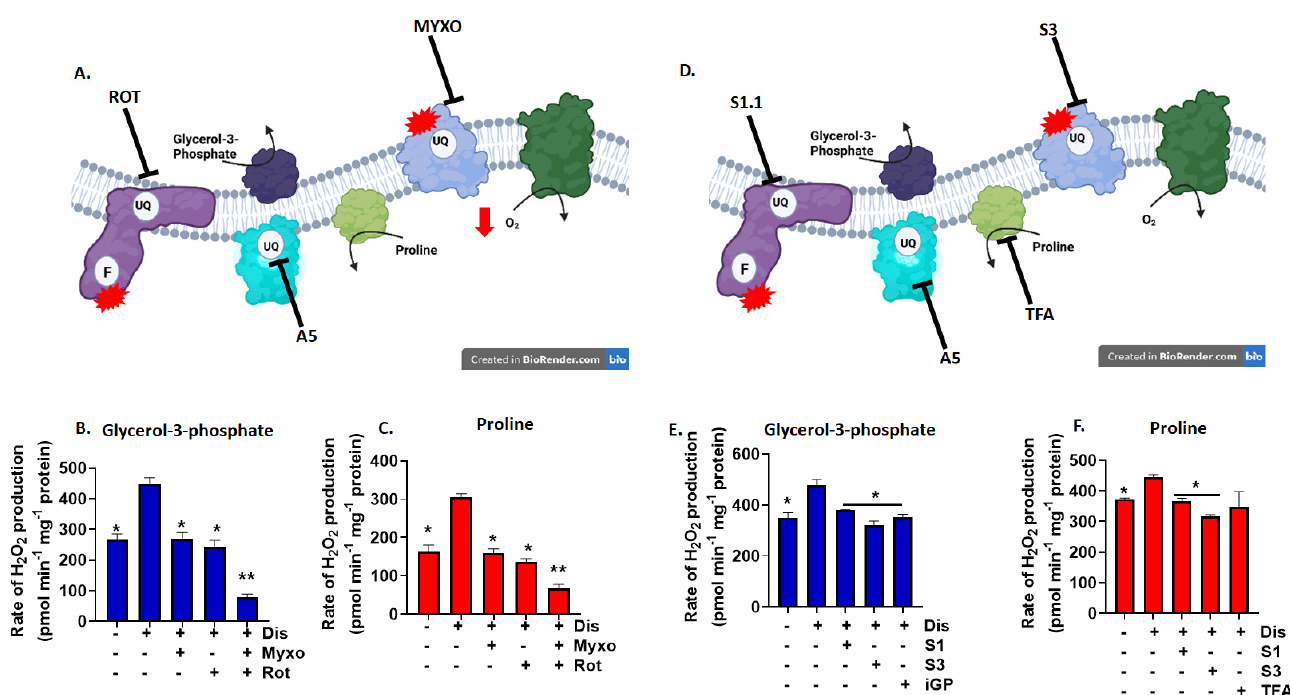
Figure 3. Complex I and III, GPD, and PRODH inhibitors impede the genesis of O 2 •− /H 2 O 2 by mitochondria oxidizing G3P or Pro. ( A ) Diagram depicting the sites of action for rotenone (ROT, I Q site; complex I) and myxothiazol (MYXO, III Q site; complex III). Atpenin A5 (A5) is a II Q inhibitor included to prevent reverse flow to complex II. Diagram was generated using Biorender.com. Mitochondria were fueled with G3P ( B ) and Pro ( C ), treated with 1000 nM disulfiram and 1 mM GSH and incubated with rotenone/myxothiazol/atpenin A5. ( D ) Diagram depicting the sites of action for S1QEL (S1, I Q site; complex I), S3QEL (S3, III Q site; complex III), iGP (GPD; glycerol-3-phosphate dehydrogenase), and tetrahydro furonic acid (TFA, PRODH; proline dehydrogenase). Diagram was generated using Biorender.com. Mitochondria were fueled with G3P ( E ) and Pro ( F ) , treated with 1000 nM disulfiram and 1 mM GSH and then incubated in S1, S3, or iGP ( E ) or TFA ( F ). Controls consisted of reactions devoid of disulfiram and respiratory inhibitors. N = 4, mean ± SEM, 1-way ANOVA with a post-hoc Fisher’s LSD test. * p ≤ 0.05, ** p ≤ 0.01.